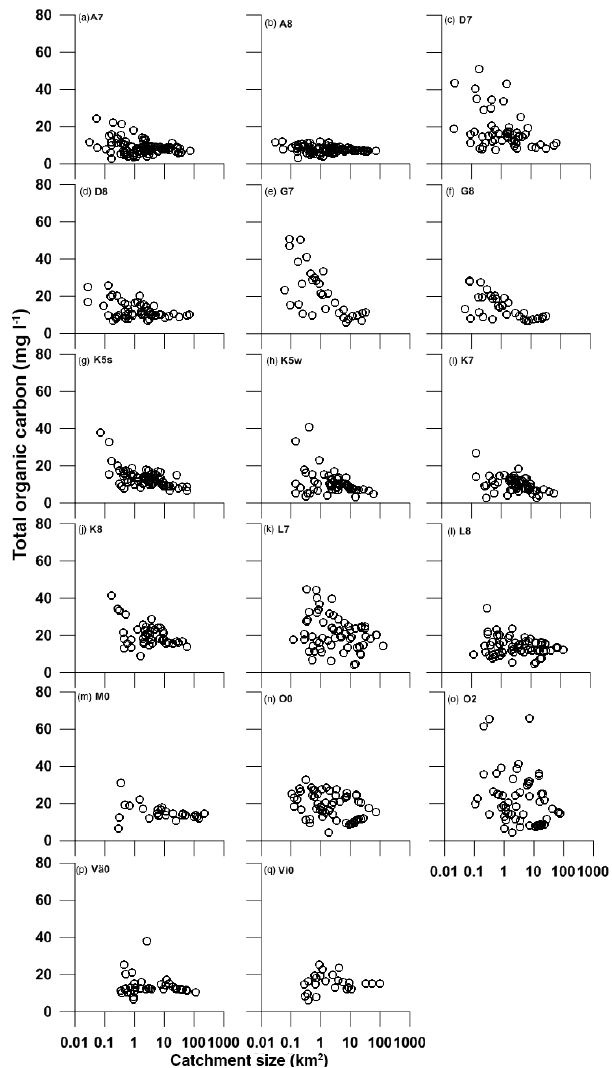
Figure 2. Total organic carbon (TOC in mgL − 1 ) as a function of catchment size (note Log 10 scale) for 17 synoptic surveys of 9 catchments; (a) is A7, (b) is A8, (c) is D7, (d) is D8, (e) is G7, (f) is G8, (g) is K5s, (h) is K5w, (i) is K7, (j) is K8, (k) is L7, (l) is L8, (m) is M0, (n) is O0, (o) is O 2 , (p) is Vä0 and (q) is Vi0. See Tables 1 and 2 for description of